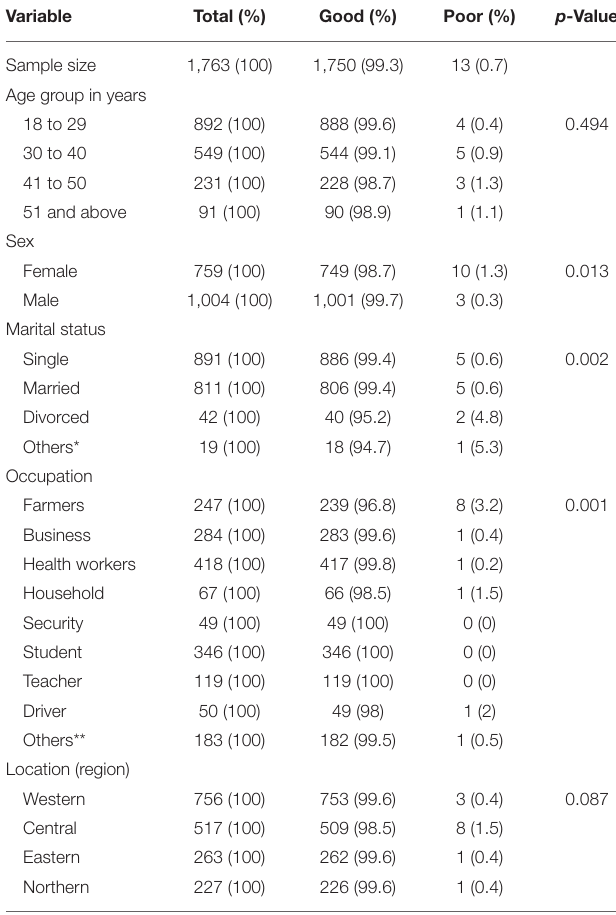
TABLE 5 | Self-reported practice toward measures for prevention of the spread of COVID-19 with socio-demographic characteristics.